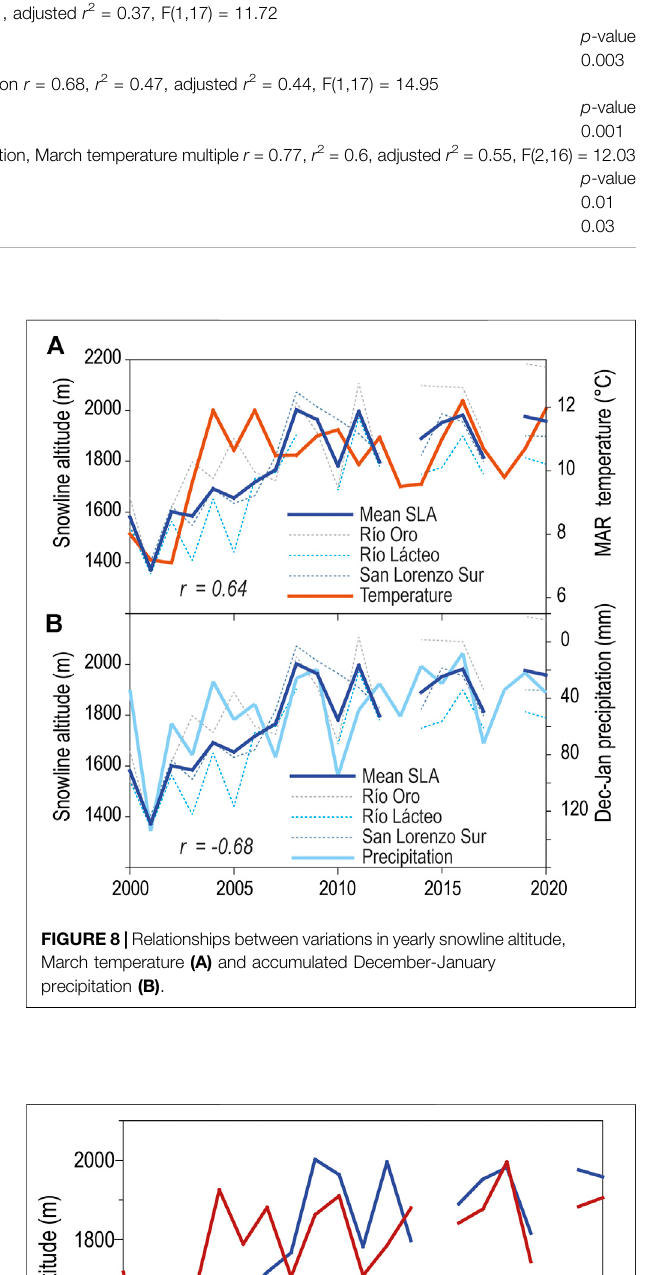
Frontiers in Earth Science |